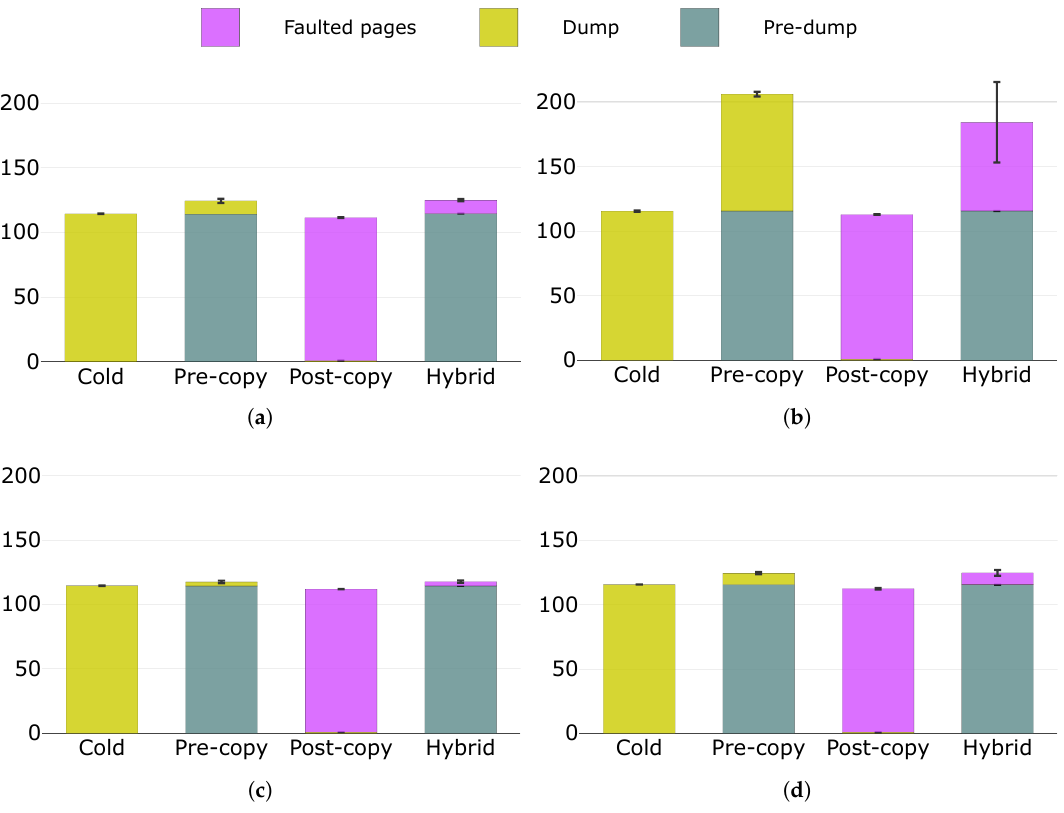
Figure 11. Amounts of transferred data (MB) with their components in evidence under: ( a ) configuration A; ( b ) configuration B; ( c ) configuration C; and ( d ) configuration